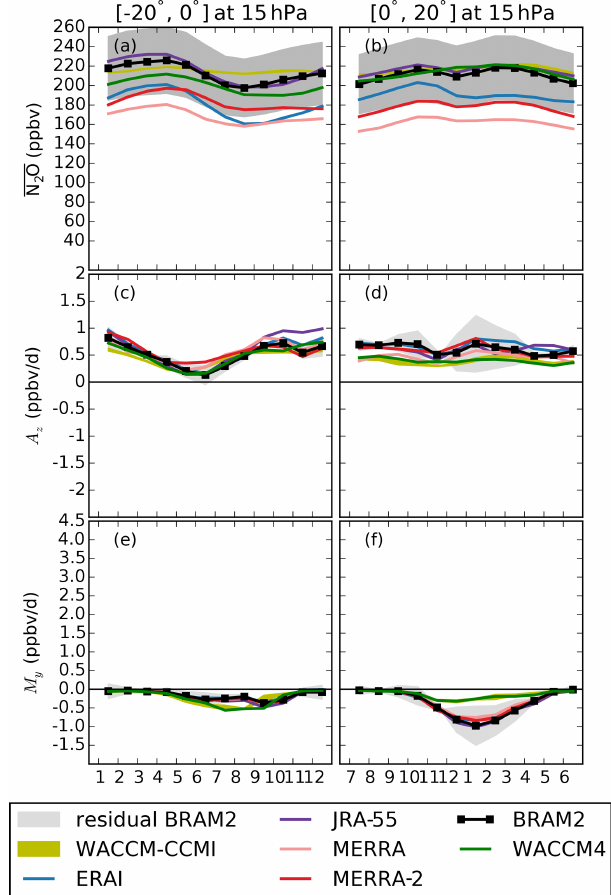
Figure 9. As for Fig. 6 but for the tropics: (a, c, e) southern tropics (0–20 ◦ S); (b, d, f) northern tropics (0–20 ◦